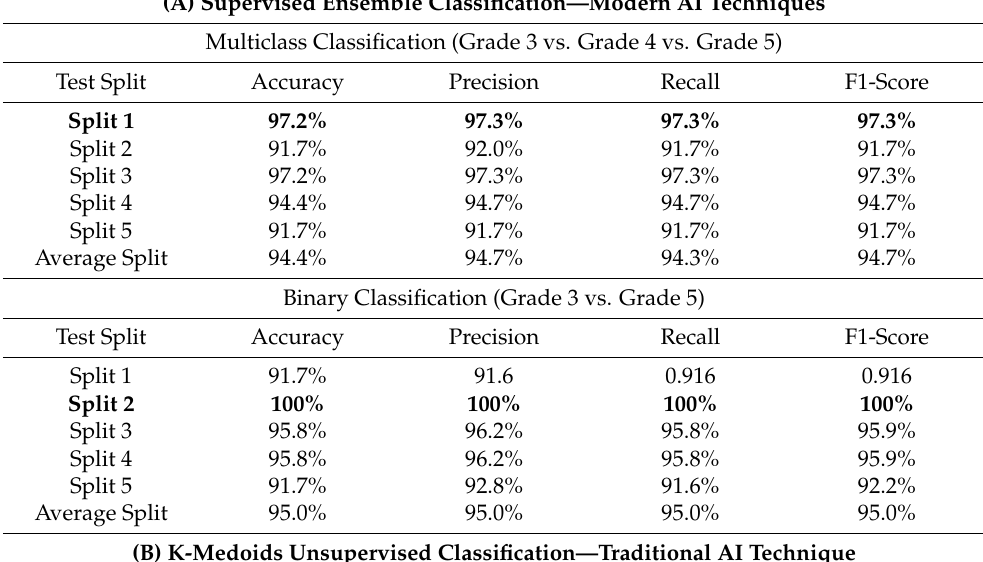
Table 3. Comparative analysis of the performance of supervised and unsupervised classification using test and whole datasets, respectively. A five-fold technique was used for both supervised and unsupervised classification. Split 1 and 2 from supervised and split 2 from unsupervised shows the best results marked in